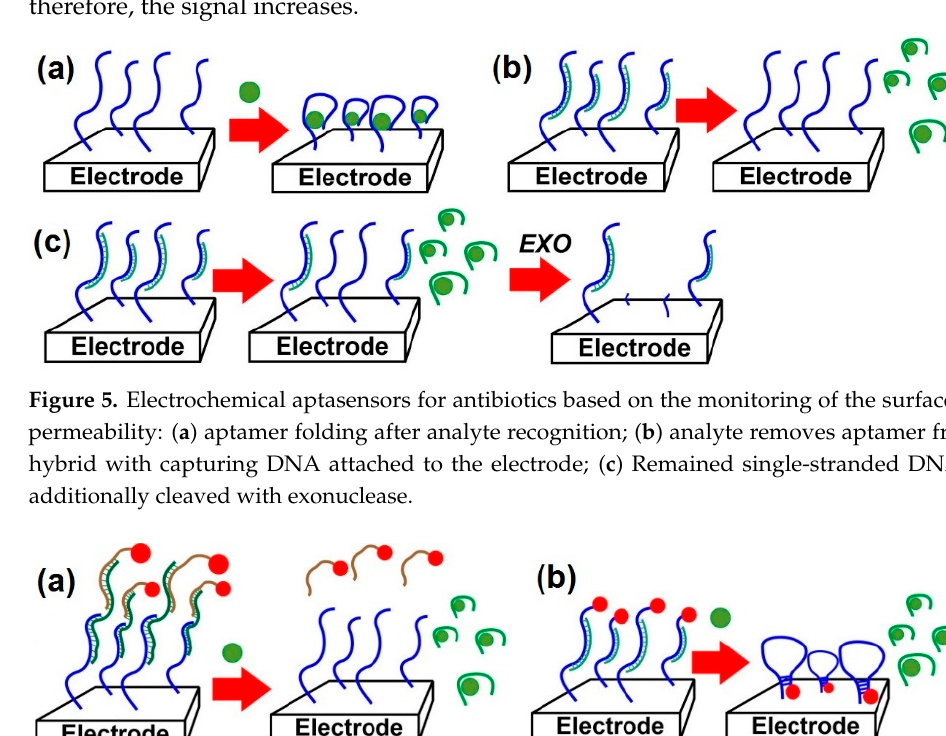
Figure 5. Electrochemical aptasensors for antibiotics based on the monitoring of the surface layer permeability: ( a ) aptamer folding after analyte recognition; ( b ) analyte removes aptamer from its hybrid with capturing DNA attached to the electrode; ( c ) Remained single-stranded DNAs are ad- ditionally cleaved with exonuclease.